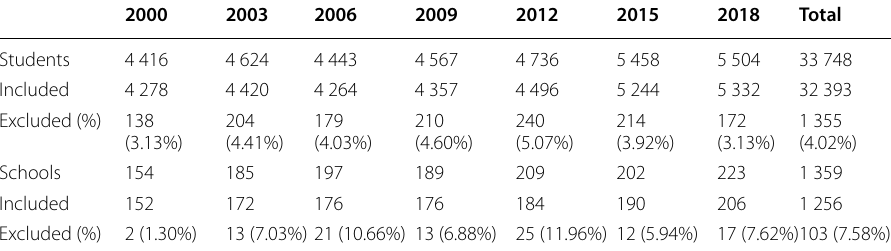
Table 1 Summary of sample sizes (n), included and excluded data for each cycle